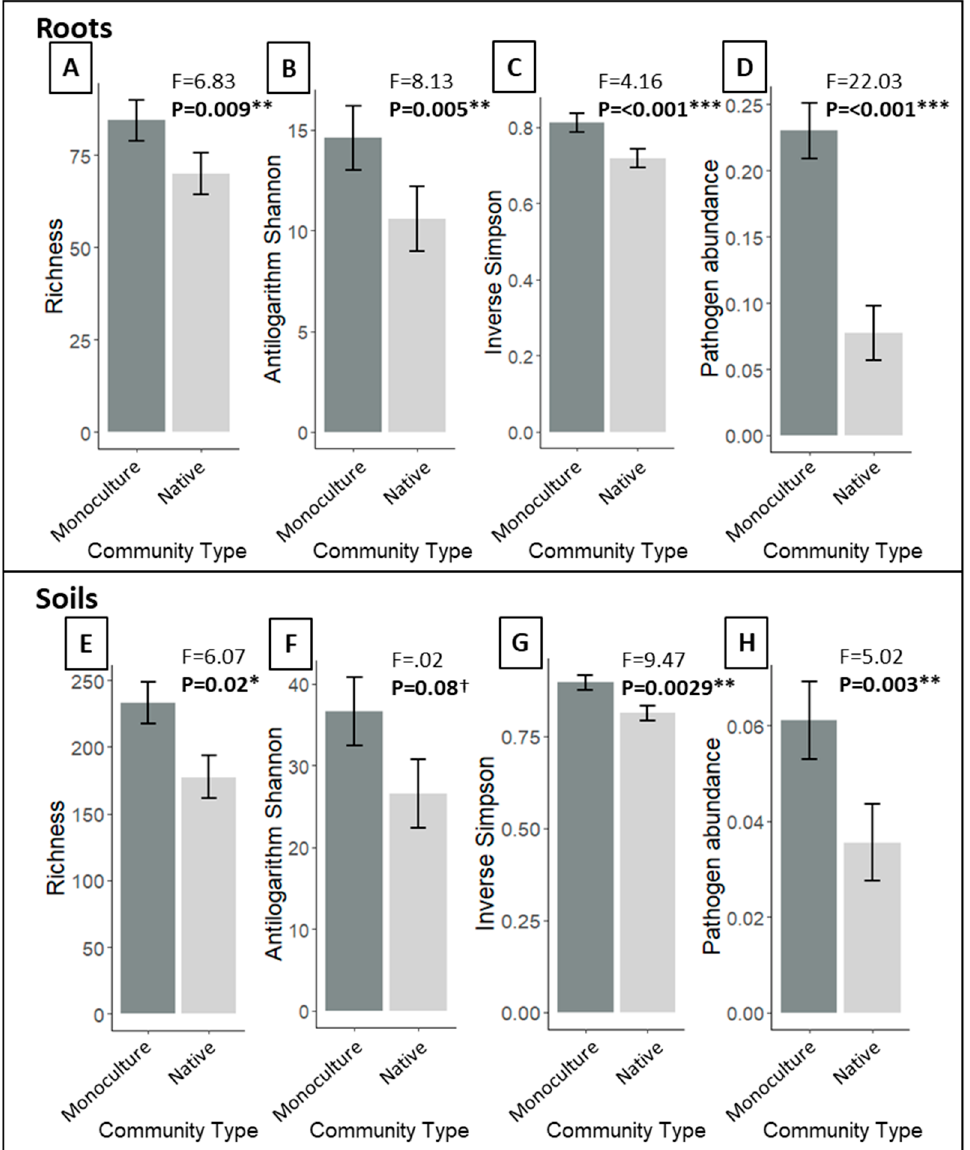
Figure 2. Fungal richness, antilogarithm of Shannon’s entropy index, inverse of Simpson’s concentration index, and total putative plant pathogen abundance in P. australis monoculture (dark grey) and native (light grey) community types. ( A – D ) display estimated marginal means and standard errors of root fungal endosphere responses to community type. ( E – H ) show estimated marginal means and standard errors of soil fungal community responses to community type. P -values less than 0.1 are highlighted in bold and labeled with the following notation: † p < 0.1, * p < 0.05, ** p < 0.01, *** p < 0.001.